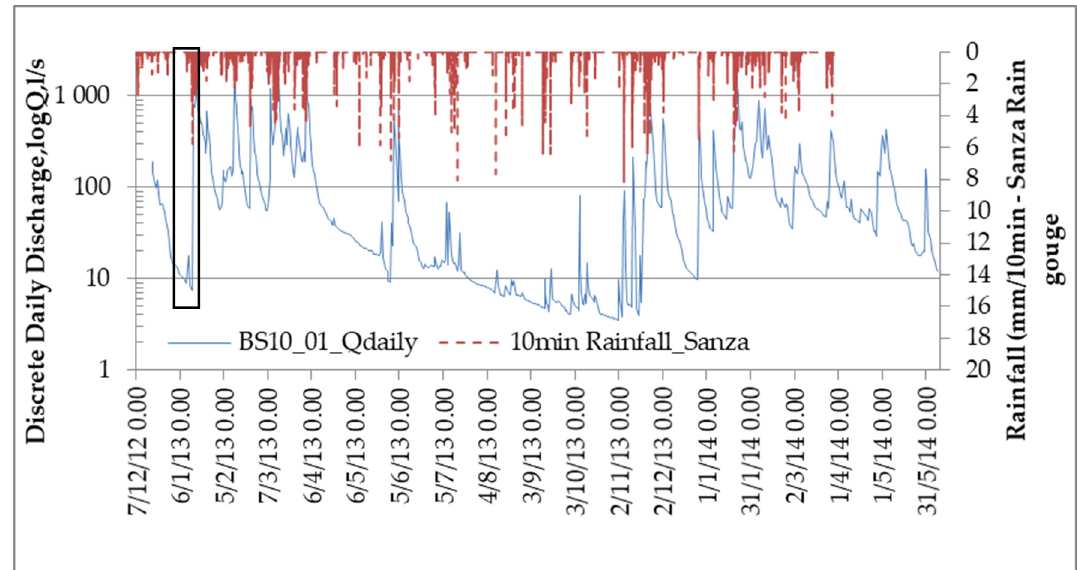
Figure 3. Discrete daily discharge collected at the main station of the Ciciriello catchment and the rain plot from the Sanza rain gauge (10 min time intervals).